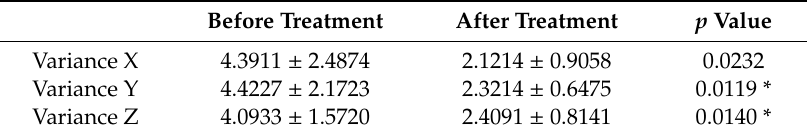
Table 2. Comparison of variance values across three axes before and after treatment.